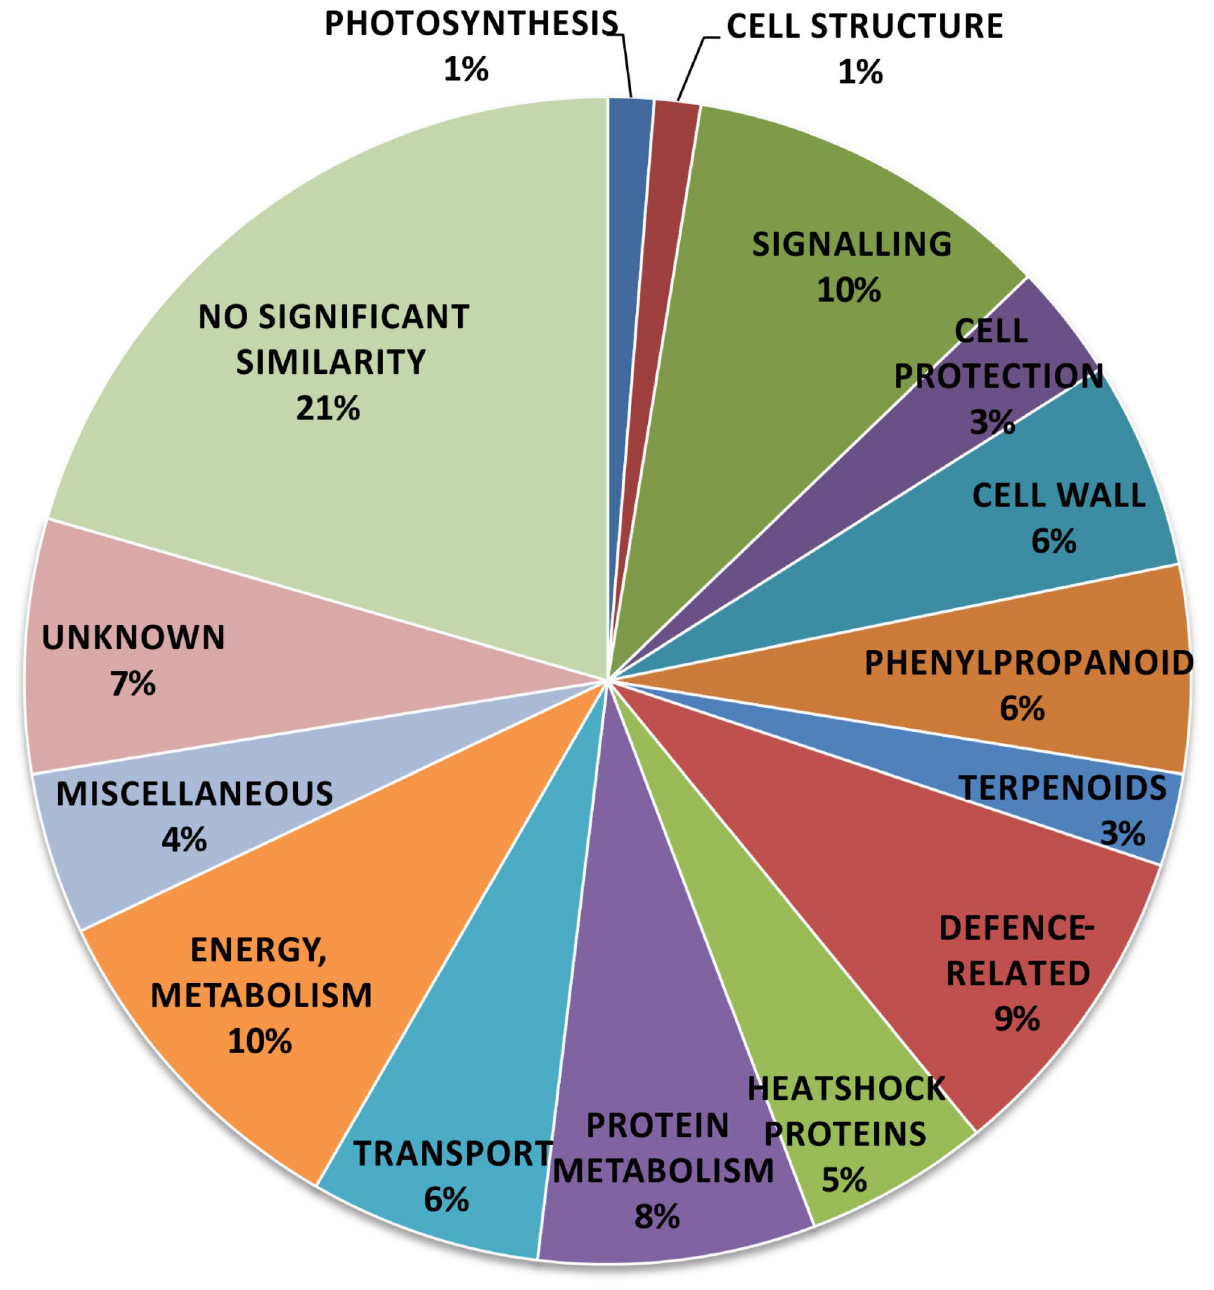
Figure 1. Pie chart representing percent ratios of putative function-based groups of the tobacco genes activated during PTI. 156 putatively PTI-activated tobacco genes were found by suppression subtractive hybridization of samples taken 6 and 48 hours after inoculation of tobacco leaves with P. syringe hrcC - mutant bacteria. BLAST nucleotide similarity search (Altschul et al. 1990) was used to assign putative functions to the sequences. Based on the identified putative functions the genes were classified into 15 groups: cell structure (2), signaling (20), cellular protection (7), cell wall (11), phenylpropanoid (9), terpenoid (4), defense related (16), heat shock (9), protein metabolism (13), transport (12), metabolism and energy (21), photosynthesis (2), miscellaneous (7), unknown function (11), no significant similarity (32). The ratios and the corresponding percentages are demonstrated in the figure. doi:10.1371/journal.pone.0102869.g001 Array-derived ratios tended to be lower than RT-PCR values, which is in accordance with the common experience that cDNA arrays tend to ‘‘shrink’’ the ratio of activation [30]. We used MAPMAN (http://mapman.gabipd.org) to visualize the differences between early (6 h) and late (48 h) sets of activated, biotic stress-related genes during PTI. Potato TC-s (Tentative